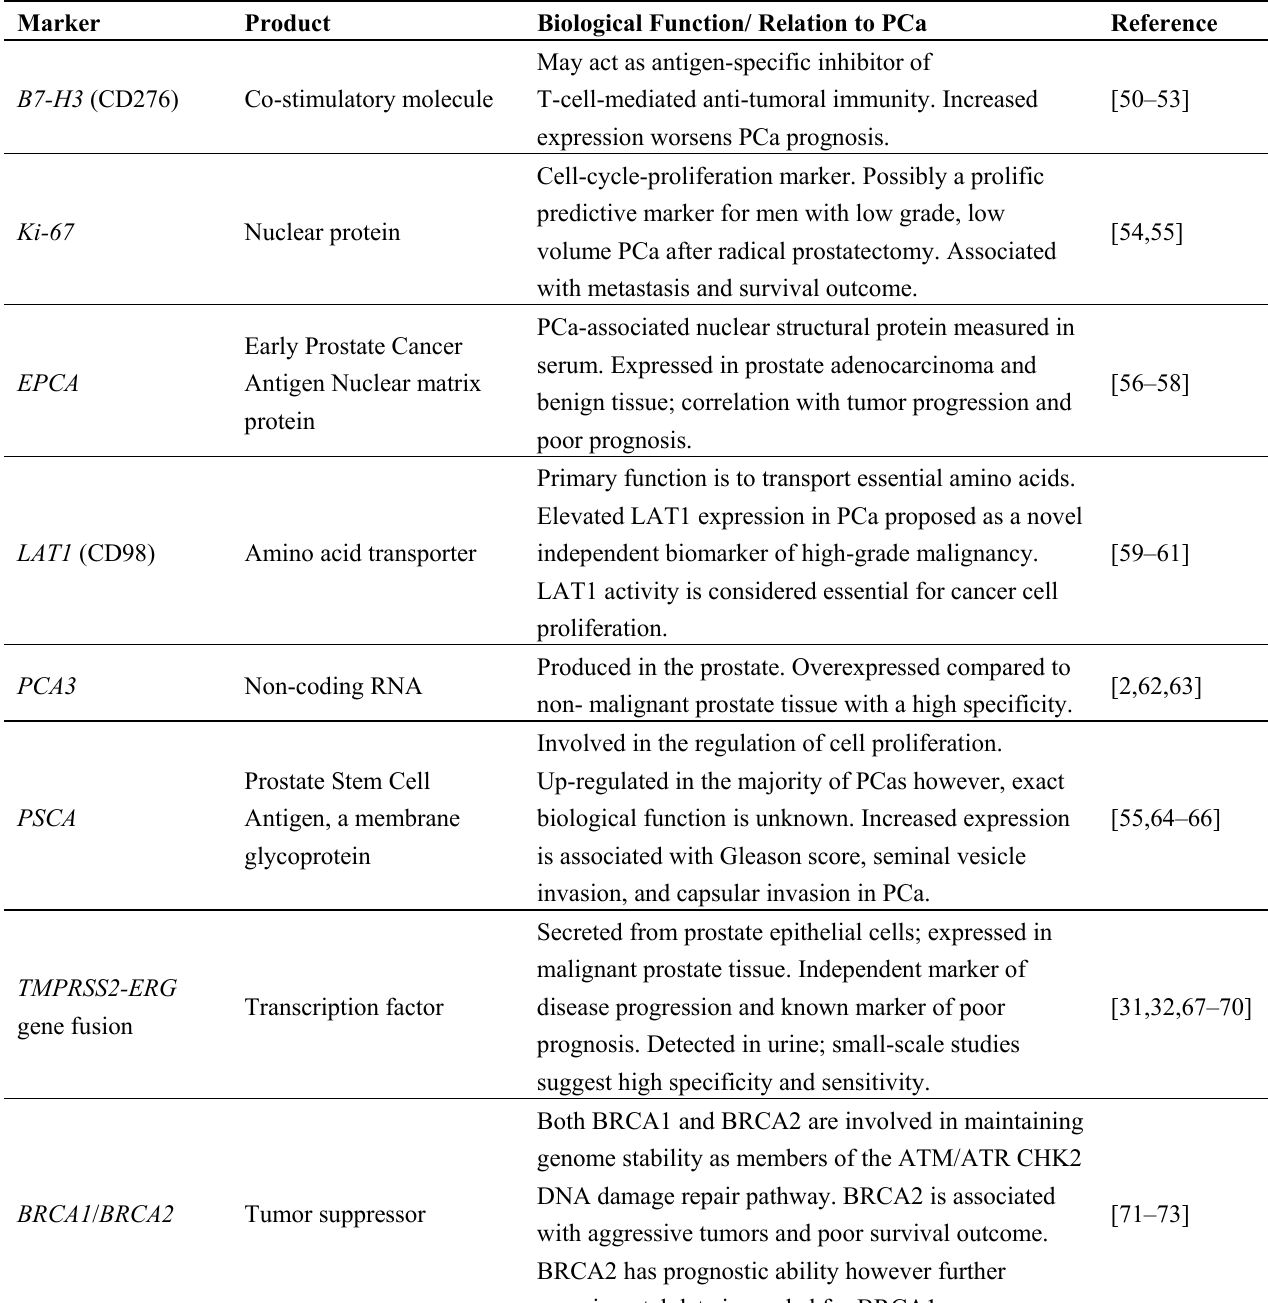
Table 1. Summary of proposed genetic biomarkers for prostate cancer diagnosis and